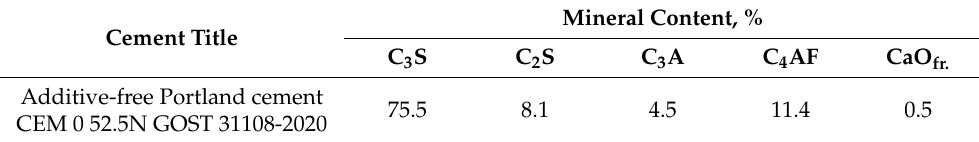
Table 3. Mineralogical composition of Portland cement.